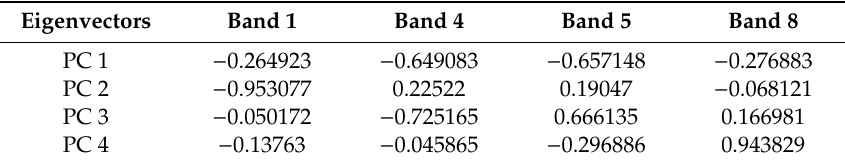
Table 3. Eigenvectors of the principal component analysis on a spectral subset of the ASTER data for detecting the propylitic alteration zones in the study